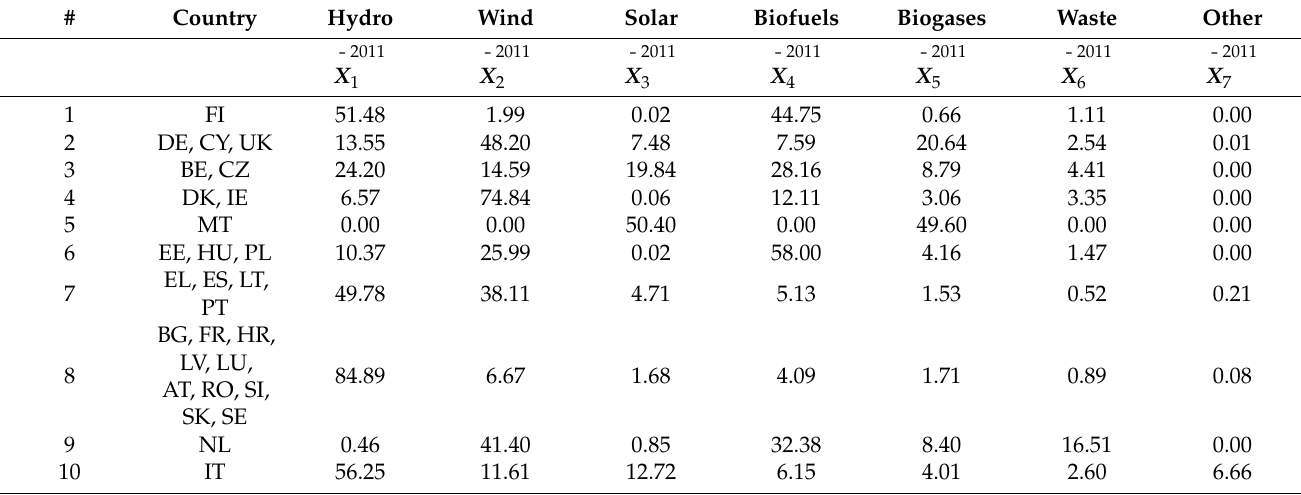
Table 6. Results of the classification of EU countries according to the shares of individual renewable energy sources in the production of electricity (clusters averages, %)—data from